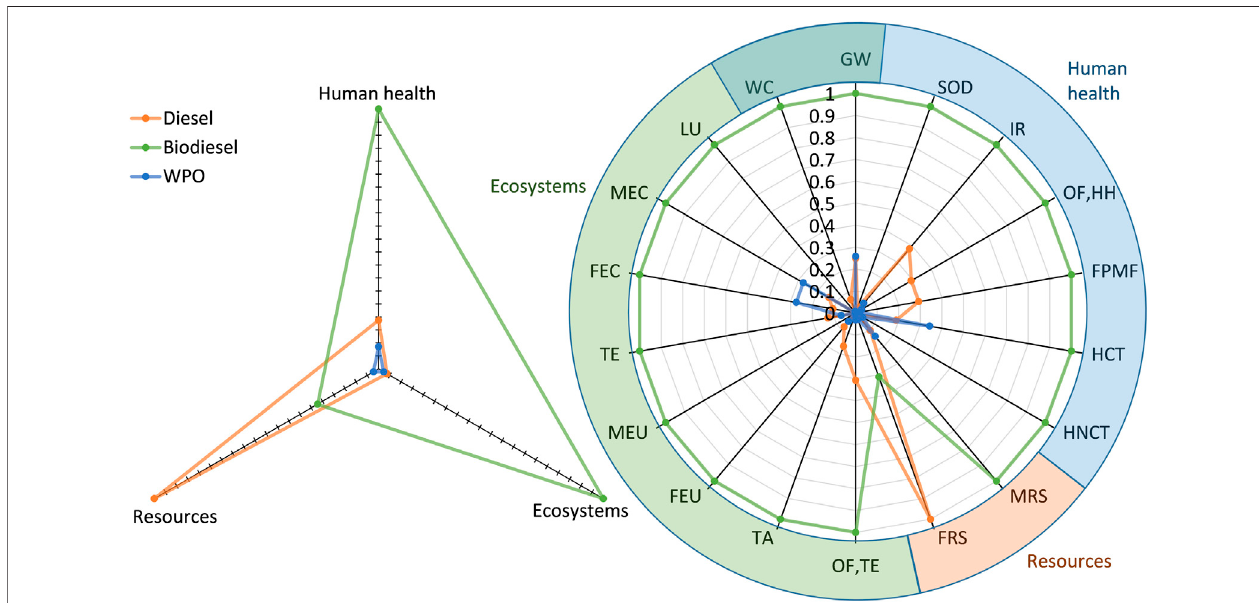
FIGURE 7 | Normalized LCA endpoint and midpoint indicators comparison for diesel, biodiesel, and WPO production pathways. GW: global warming; SOD: stratosphericozonedepletion;IR:ionizingradiation;OF,HH:ozoneformation,humanhealth;FPMF: fi neparticulatematterformation;OF,TE:ozoneformation,terrestrial ecosystems; TA: terrestrial acidi fi cation; FEU: freshwater eutrophication; MEU: marine eutrophication; TE: terrestrial ecotoxicity; FEC: freshwater ecotoxicity; MEC: marine ecotoxicity;HCT:humancarcinogenictoxicity;HNCT: humannon-carcinogenictoxicity; LU:landuse;MRS:mineralresourcescarcity;FRS: fossilresource scarcity; WC: water consumption. WPO: plastic waste pyrolysis oil. Endpoint and midpoint values are available in Supplementary Table S2